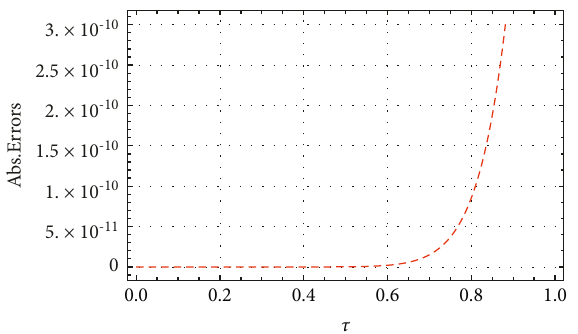
Figure 11: The absolute error for the real part of Example 2.